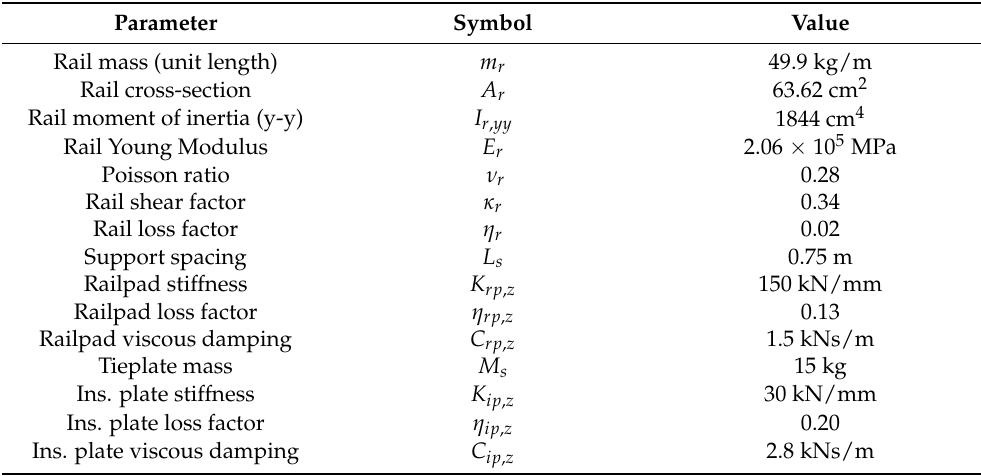
Table 2. Track data and list of